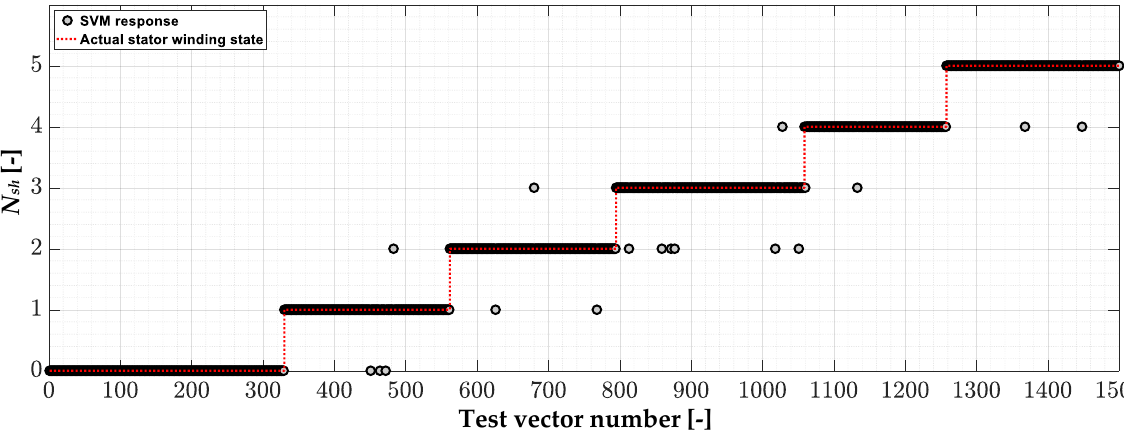
Figure 17. Responses of the SVM-based fault classifier model to the test vectors.